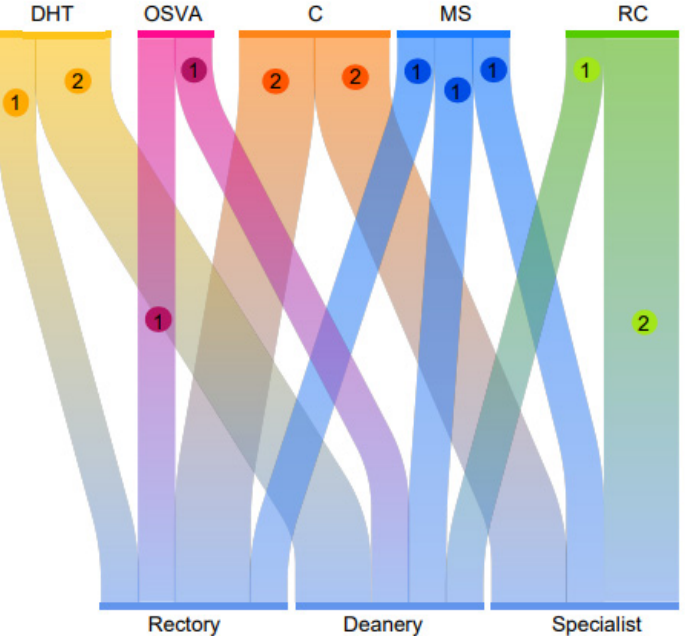
Figure 6. Sankey diagram. Own source, 2022. 1 = Absolute 2 = Relative.